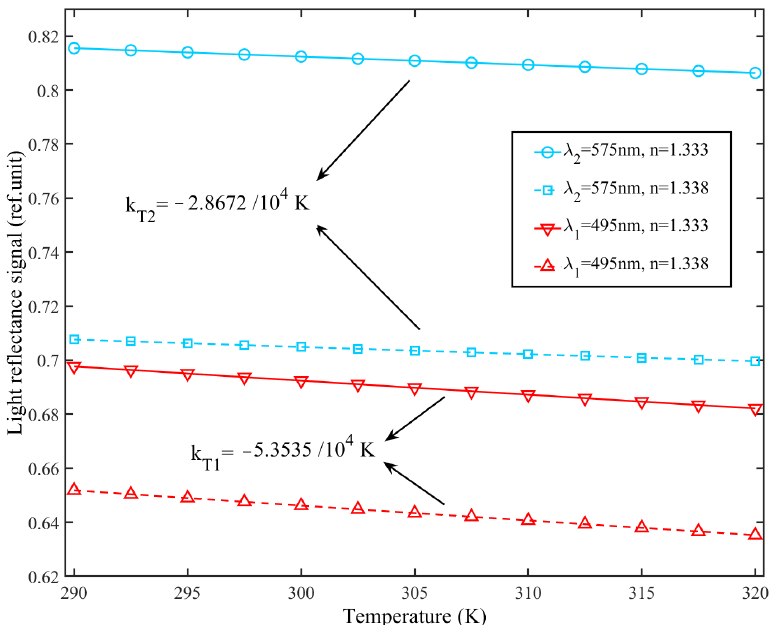
Figure 7. SPR reflected signal shifts versus temperature for RI equalling 1.333 RIU and 1.340